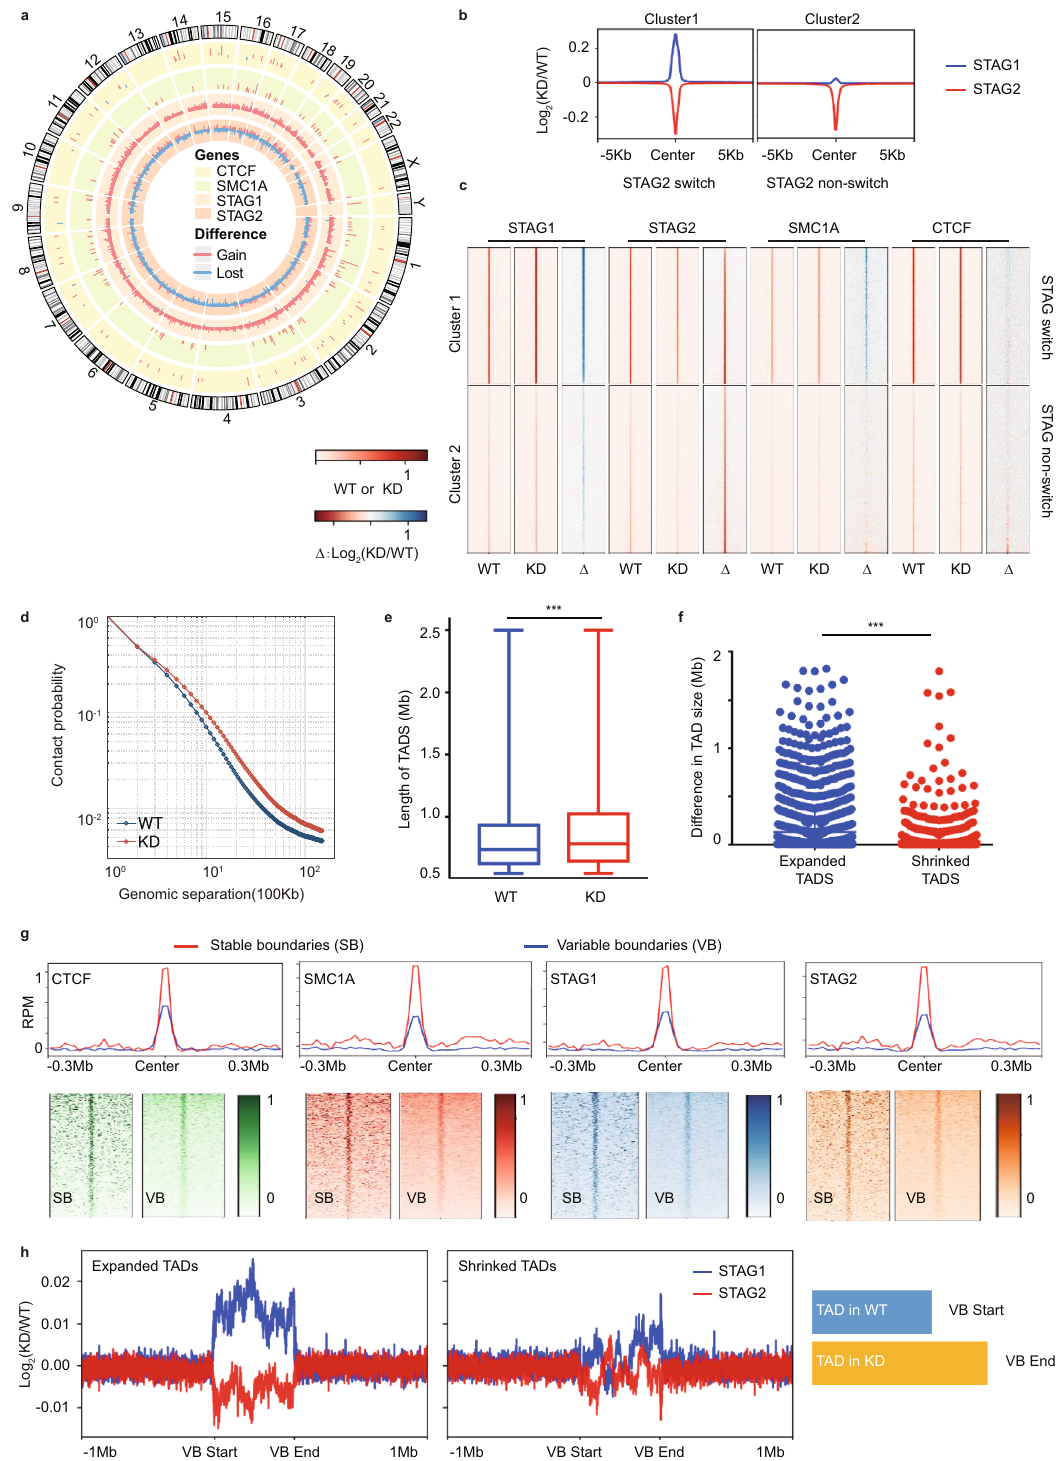
(Supplementary Fig. 6g). Furthermore, we analyzed patterns of H3K27ac binding and H3K27ac-associated DNA loop at the sites of STAG2 to STAG1 switch versus non-switch sites. We extracted average H3K27ac signals for each switched and non-switched site and compared the mean of the H3K27ac at these sites between WT and KD. Interestingly, we observed signi fi cant gains of H3K27ac signal upon STAG2 KD at switch sites ( p < 2.2e-16, Wilcox test), but not at non-switch sites ( p = 0.1368, Wilcox test) (Fig. 2e),